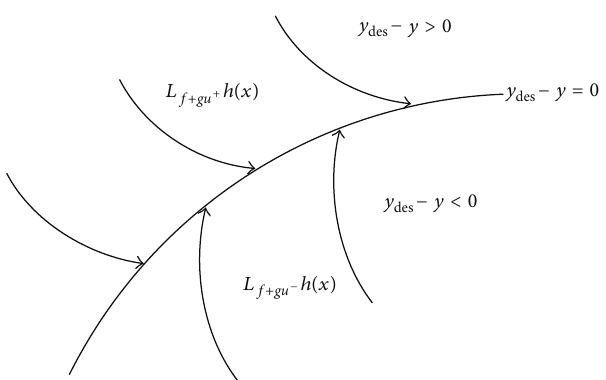
Figure 3: The nonlinear dynamic inversion regime on the NDI